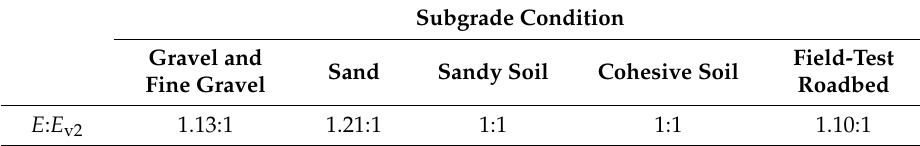
Table 9. Ratio of the elastic modulus to strain modulus according to the subgrade